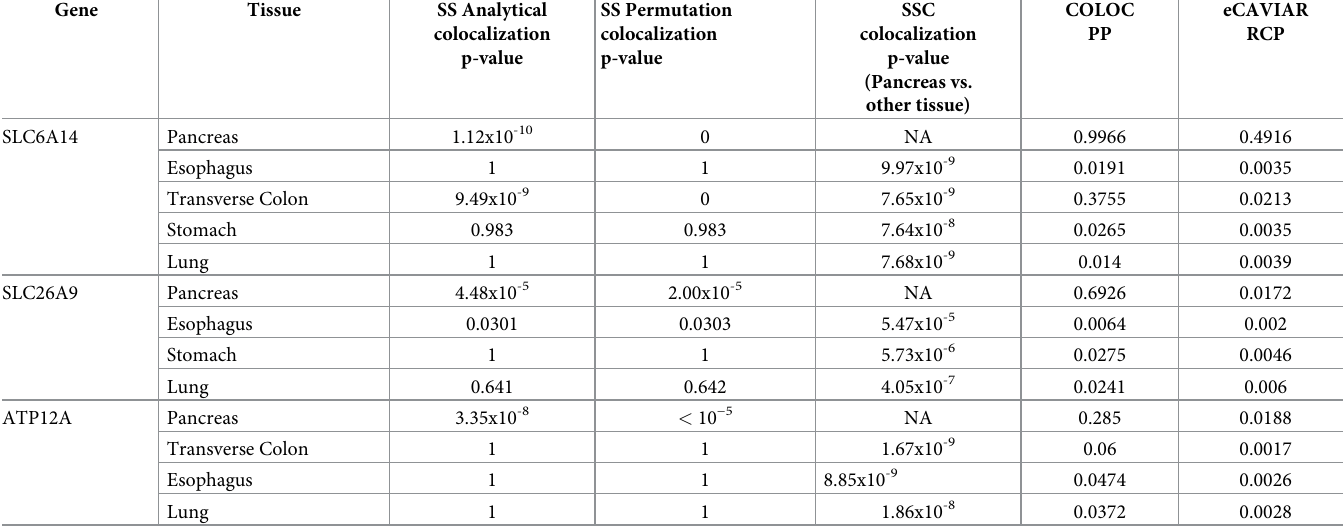
Table 3. Results of Simple Sum colocalization and contrasting colocalization analyses for the three meconium ileus genome-wide significant loci, and colocalization posterior probabilities from COLOC and eCAVIAR. The eQTL evidence is the GTEx p-value based on the -log10(eQTL p) scale for a specified gene and tissue. The meconium ileus-SNP association evidence is the w 2 -distributed Wald test statistic obtained in this study. Analytical (and permutation-based) Simple Sum (SS) colocaliza- 1 tion p-values correspond to each individual tissue and evaluates if the eQTLs and meconium ileus-associated variants colocalize. Simple Sum contrasting (SSC) colocaliza- tion p-value evaluates if the eQTLs in the pancreas colocalize with meconium ileus-associated variants more than eQTLs in another tissue; NAs are listed for the pancreas since we do not contrast pancreas with itself. All p-values are one-sided because only positive association implies eQTL-association colocalization (i.e. eQTL peaks coincide with association peaks). COLOC [43] PP represents the posterior probability of eQTL-association colocalization calculated for each individual tissue. eCAVIAR [44] calcu- lates SNP-level colocalization posterior probability (CLPP) for each variant in a locus for a given gene and in a given tissue. The regional colocalization probability (RCP) can be defined by summation of the SNP-level CLPP in a given LD block; RCP is recommended in [49] and the results are provided in the ‘eCAVIAR RCP’ column. eCA- VIAR maximum regional CLPP provides similar qualitative results as eCAVIAR RCP thus are not shown